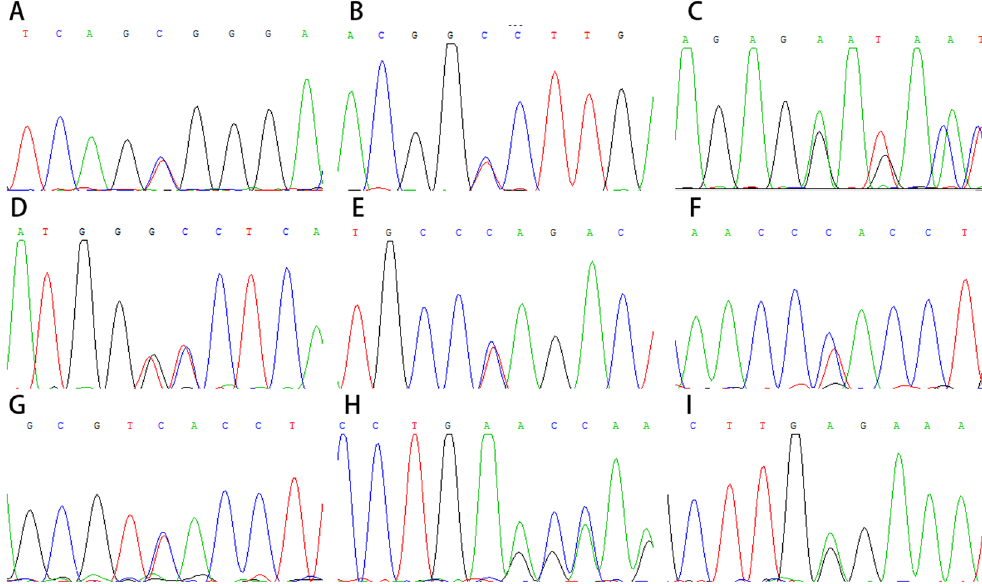
Figure 2. Sequencing results of nine novel disease-causing mutations. ( A ) Forward sequencing showed c.26C > T mutation of CRYBA4 gene in patients from family 1. ( B ) Reverse sequencing showed c.53G > A mutation of CRYGS gene in patients from family 4. ( C ) Forward sequencing showed p.G91del mutation of CRYBA1 gene in patients from family 5. ( D ) Forward sequencing showed c.224_225GC > TT mutation of CRYGS gene in patients from family 7. ( E ) Forward sequencing showed c.607C > T mutation CRYBA1 gene in patients from family 9. ( F ) Reverse sequencing showed c.452G > A of CRYBB2 gene in patientsfamily 17. ( G ) Reverse sequencing showed c.625 + 3A > G mutation of BFSP1gene in patients from family 19. ( H ) Forward sequencing showed c.795delA mutation of PAX6 gene in patient from family 24. ( I ) Forward sequencing showed c.342G > A mutation of PAX6gene in patients family 27.